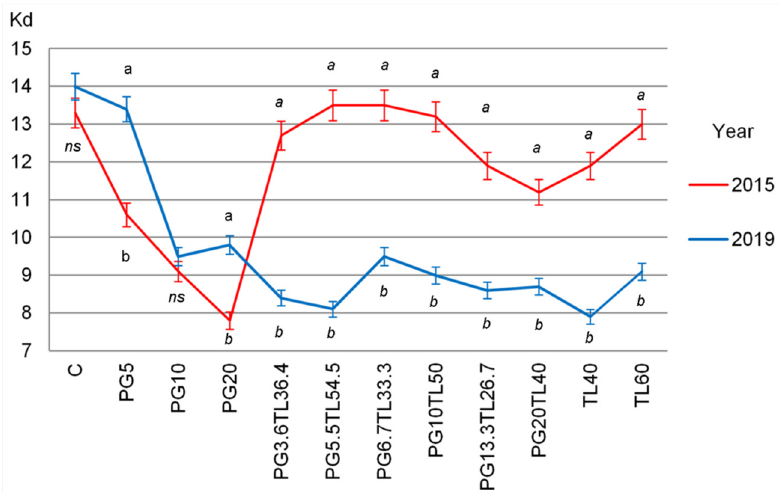
Figure 3. Effect of treatments and years on the Kachinsky dispersion coefficient (K d ) at the beginning and end of the experiment (0–20 cm soil layer). Various letters denote significant differences at p < 0.01, ns – not significant.